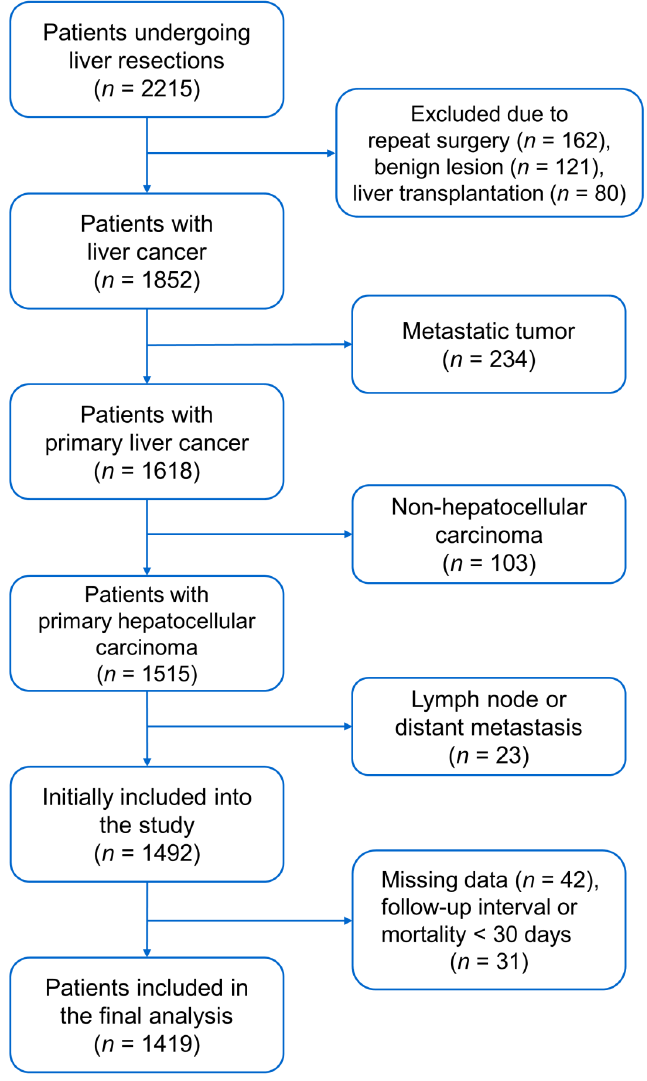
Figure 1. Flow diagram for patient selection.